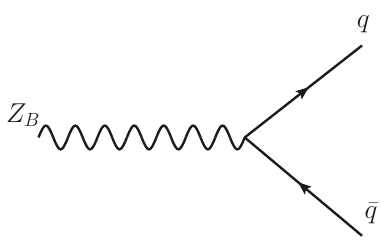
Figure 10 . Leptophobic gauge boson